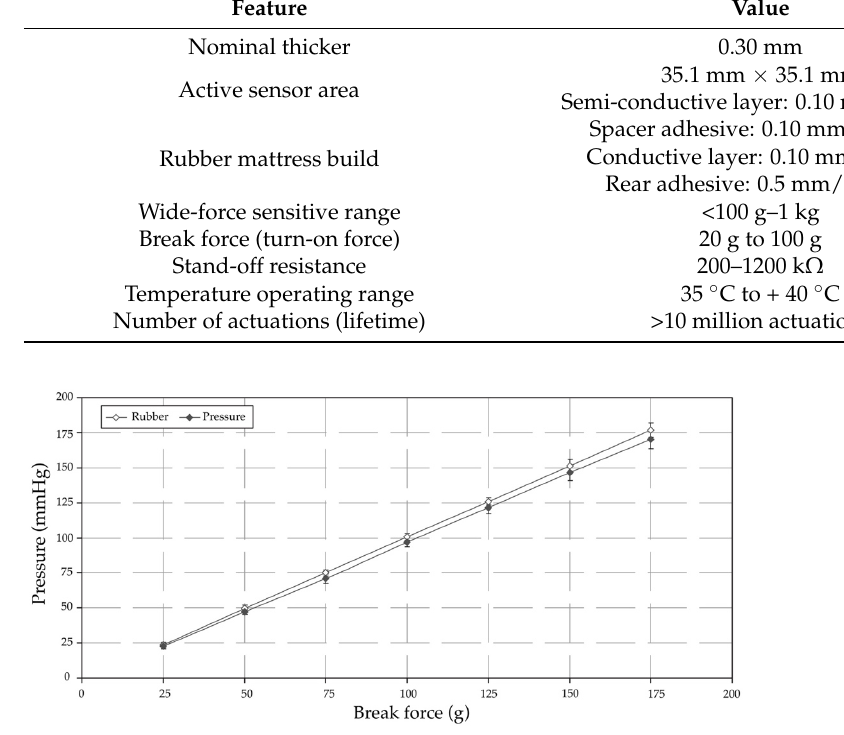
Figure 19. Repeatability of temperature and humidity values. Figure 20. The repeatability test of the pressure, temperature, and humidity sensors.